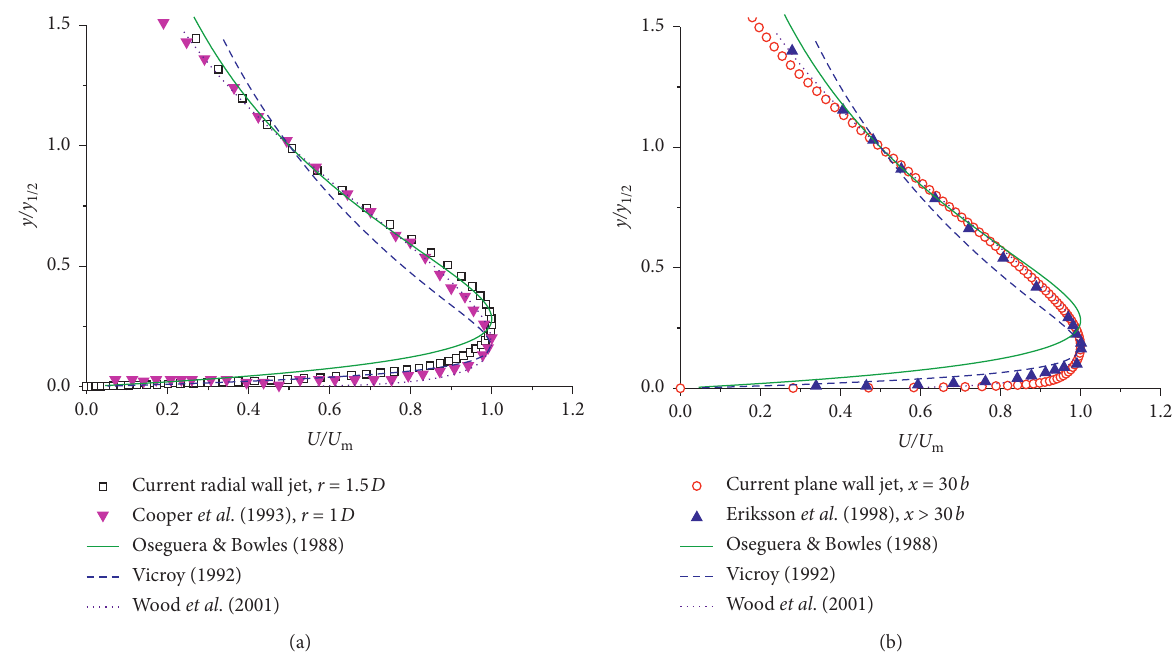
Figure 5: Vertical mean velocity profiles in outer scales. (a) Radial wall jet. (b) Plane wall jet.